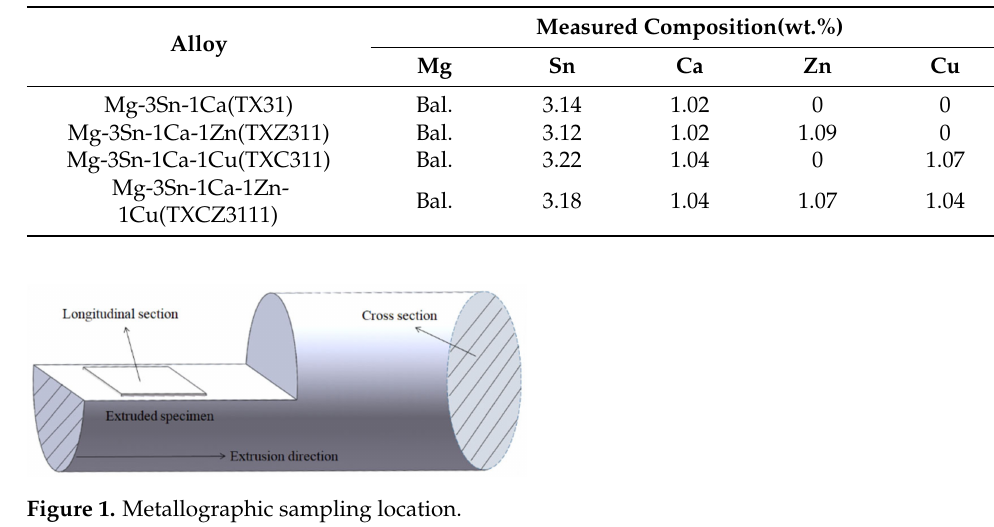
Table 1. Actual chemical composition of as-cast alloy.